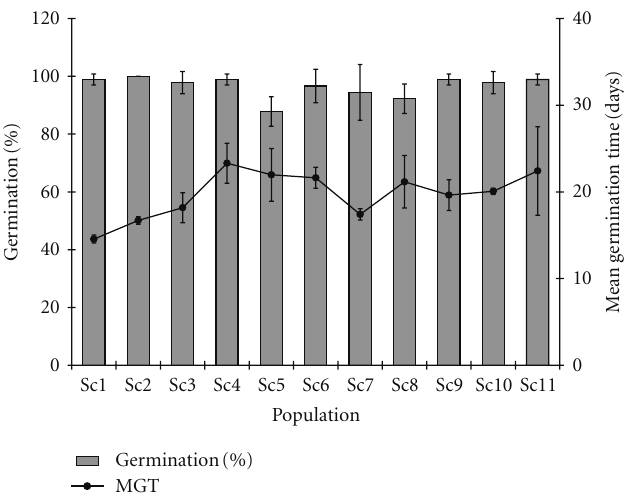
Figure 2: Mean seed germination and mean germination time (MGT in days) during initial testing in Swertia chirayita ( vertical bars indicate the standard deviation; 30 seeds × 3 replicates per population used